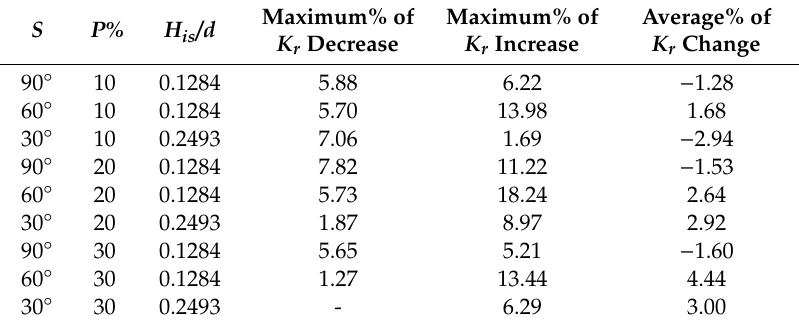
Figure 14. Effect of the number of walls on K r . θ = 30°, and H is / d = 0.2493. ( a ) P = 10%, ( b ) P = 20%, and ( c ) P = 30%. Table 6. The maximum percentage of decrease and increase, and the average percentage of change in K r due to addition of a second wall.